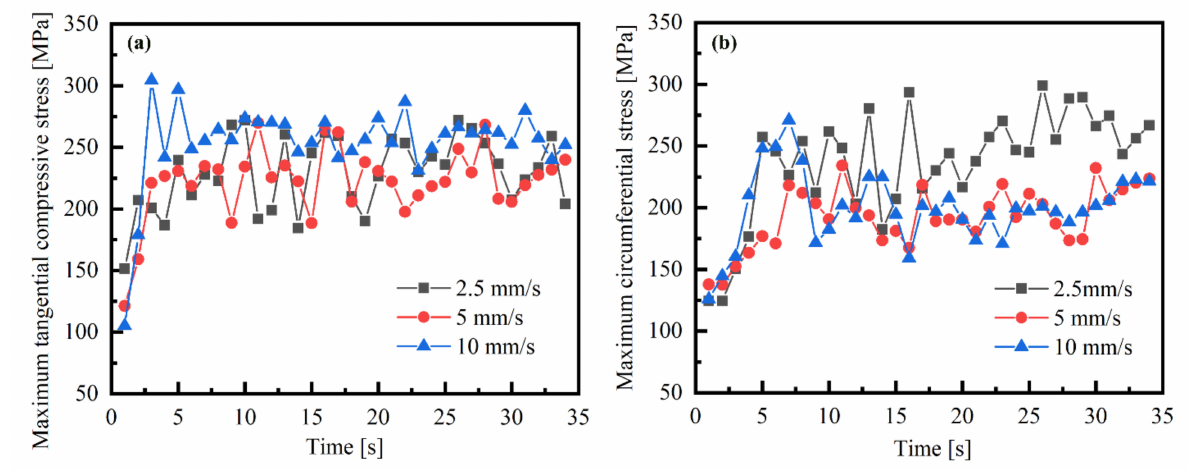
Figure 21. History curves of the maximum stress with different feed rates of the tube (distance between the inductor and bending roller: 50 mm): ( a ) The maximum tangential compressive stress; ( b ) the maximum circumferential stress.